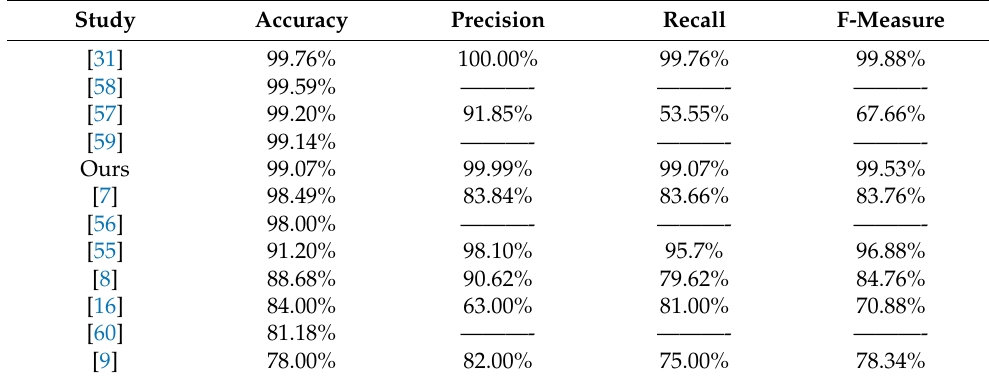
Table 14. Comparison of the accuracy, precision, recall, and F-measure of this study with others. The information is ordered by level of accuracy. Our study is in the fifth row but presents the second highest levels of precision, recall, and F-measure in comparison with other studies. These results mean that our study is placed among the best when compared against the